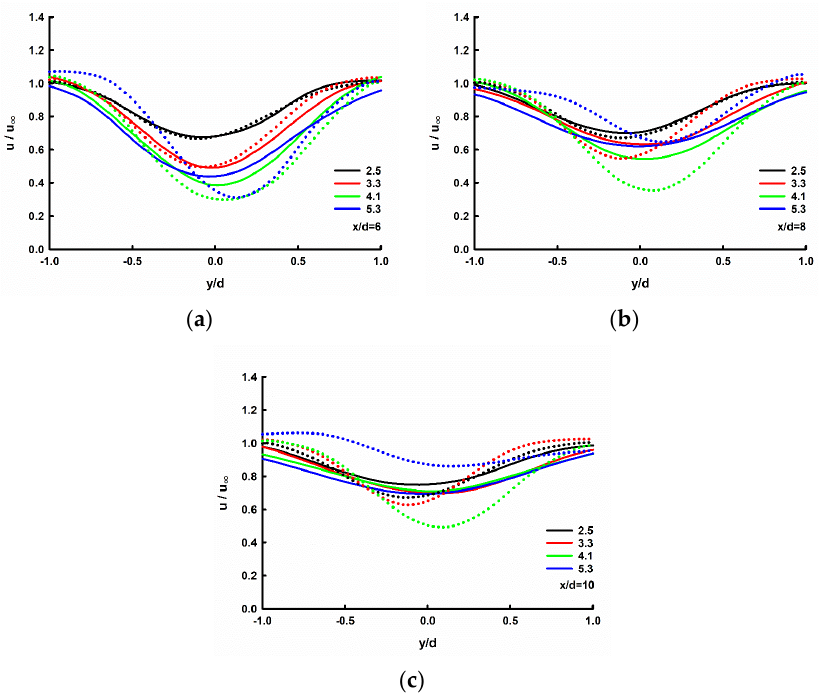
Figure 15. Time averaged normalised stream-wise wake velocity along −0.75 d ≤ y/d ≤ +0.75 d for different tip speed ratios at near-wake distances. ( a ) x/d = 6; ( b ) x/d = 8; ( c ) x/d = 10. Instantaneous normalised stream-wise wake velocity profiles are represented using dotted lines.